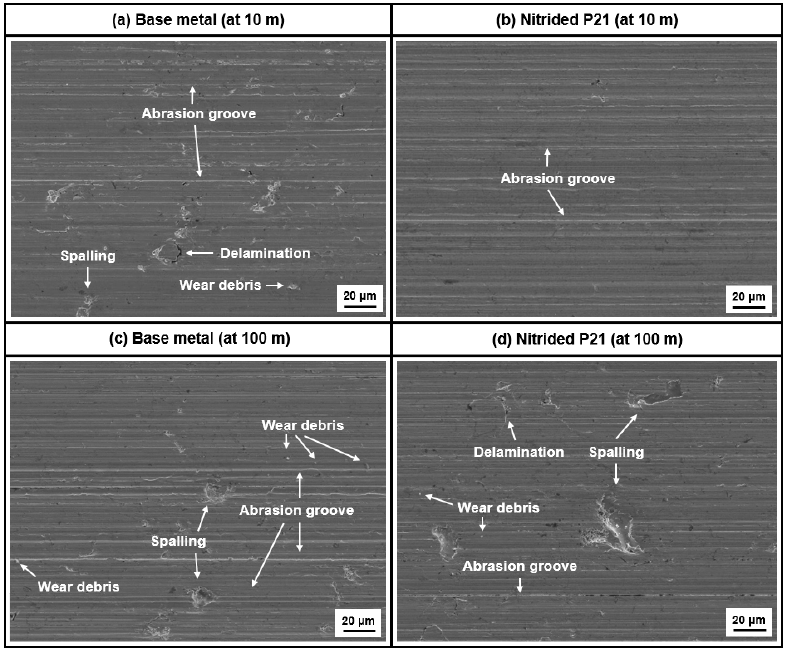
Figure 12. Surface morphology obtained from the pin-on-disk test for the ( a ) BM after 10 m of sliding distance, ( b ) LN P21 after 10 m of sliding distance, ( c ) BM after 100 m of sliding distance, and ( d ) LN P21 after 100 m of sliding distance.